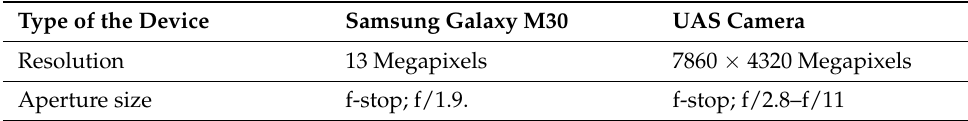
Figure 4. Representative images with corrosion. Table 1. Camera specifications.